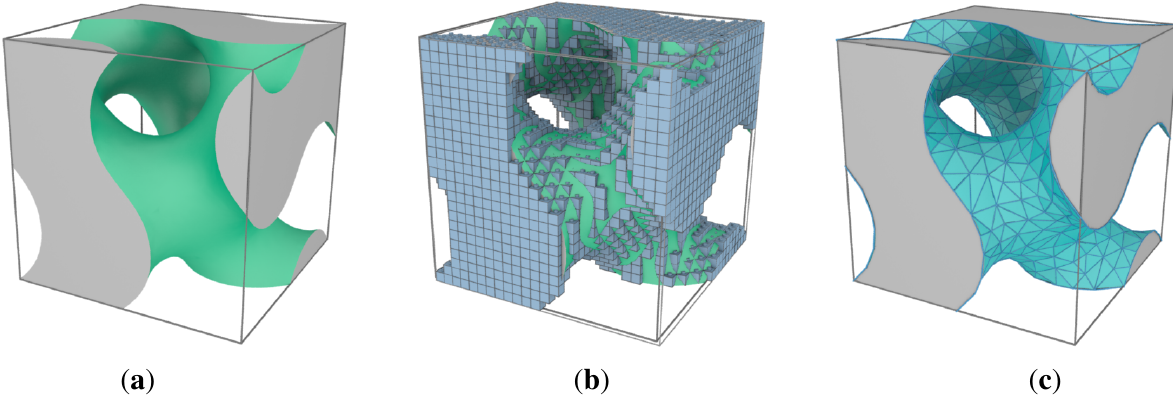
Figure 3. Mesh and voxel representation of photonic crystals with a single gyroid structure: ( a ) the single gyroid geometry [21,22], which has attracted recent attention as a photonic material [5,23–27], is a two-phase geometry with cubic symmetry with a solid (gray) and a void (transparent) component, each of which forms a labyrinth- or network-like